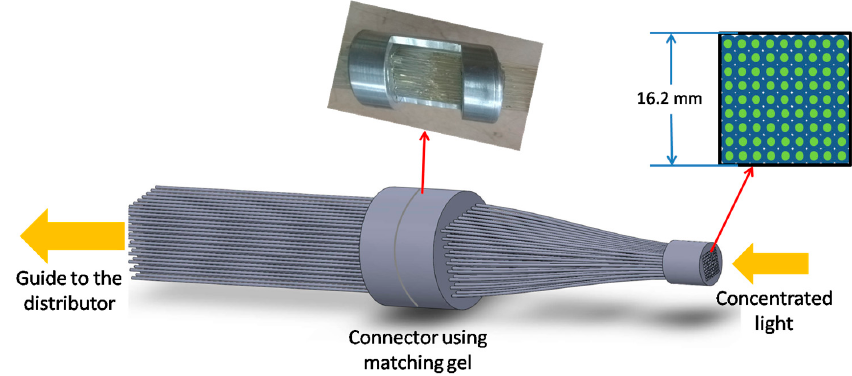
Figure 6. The structure of the bundle using a combination of silica optical fibers (SOFs) bundle and plastic optical fibers (POFs) bundle in which they are connected together by connector using matching gel.